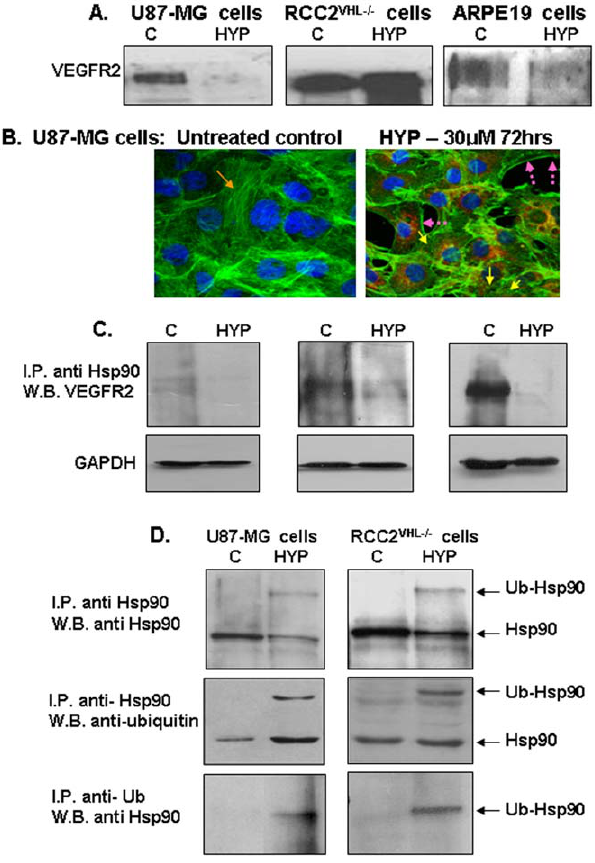
Figure 4. Effects of hypericin on complex formations between VEGFR2, Hsp90 and on HOP-hsp70 intermediate complexes. [A]. Western blot analyses of VEGFR2 protein levels in cytosolic extracts from untreated control cells (C), or cells treated with 30 m M hypericin for 72 hrs (HYP). [B]. Staining of U87-MG cells with Phalloidin-FITC. (1) Untreated cells and (2) cells treated with hypericin 30 m M for 72 hrs. Orange arrows show F-actin filaments; yellow arrows depict collapsed actin globules following exposure to hypericin. [C]. VEGFR2-hsp90 complex formation following treatment with hypericin 30 m M for 72 hrs. Results of immunoprecipitation with anti-Hsp90 antibody and development of Western blots with anti-VEGFR2 antibody. Hypericin diminished VEGFR2-Hsp90 complex formation. [D]. Induction of forced hsp90 poly-ubiquitination by hypericin (30 m M for 72 hrs) in human cancerous cell lines. Top panel – immunoprecipitation with anti-hsp90 and Western blot with anti-hsp90 antibody (control); middle panel - immunoprecipitation with anti-hsp90 and Western blot with anti- ubiquitin, and lower panel immunoprecipitation with anti-ubiquitin and Western blot with anti-hsp90. (I.P – immunoprecipitation; W.B. – Western blots).